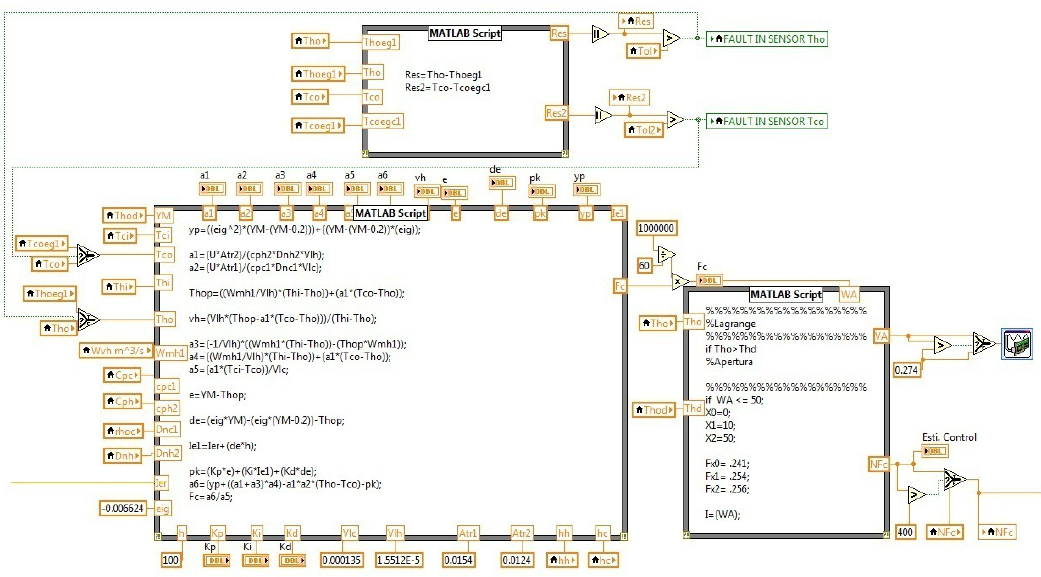
Figure 13. Fault detection